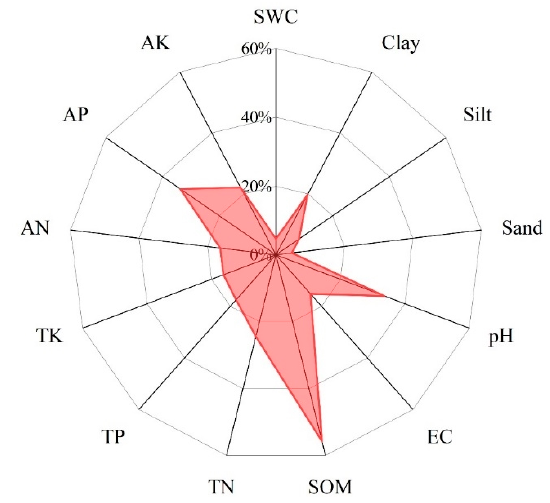
Figure 6. Usage frequency of different indicators in the MDS.